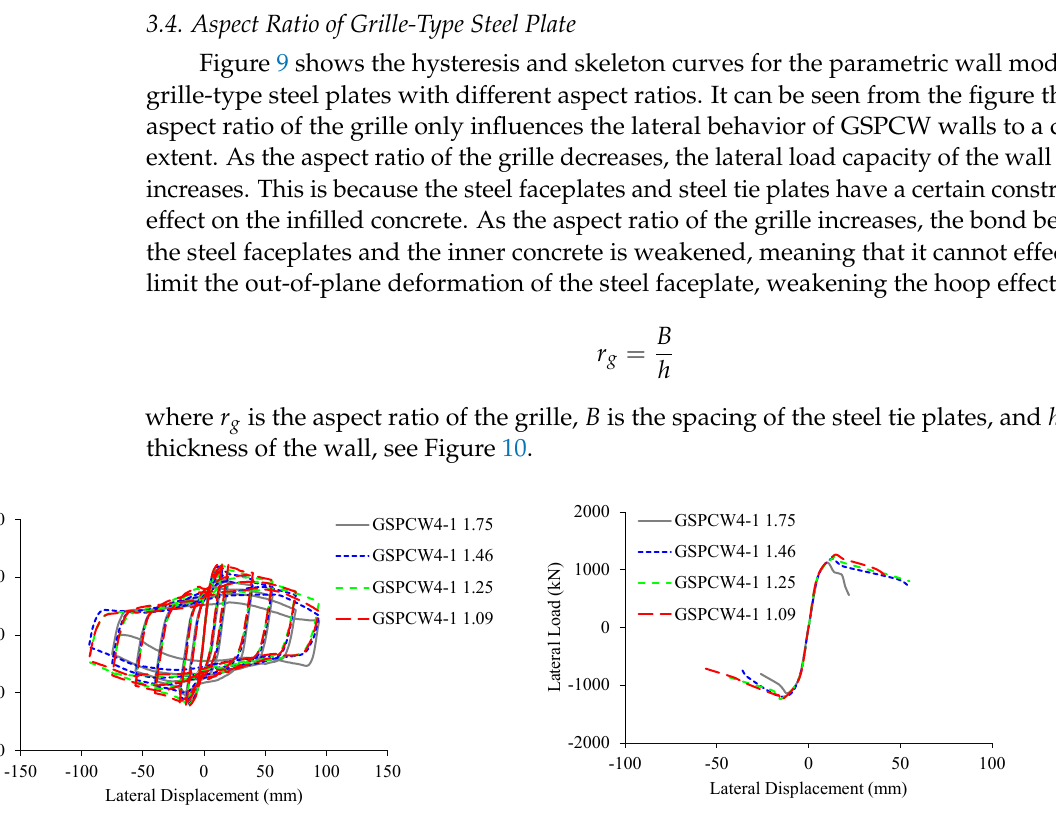
Figure 8. Influence of the height-to-width ratio: ( a ) load–displacement hysteresis curves, and ( b ) skeleton curves.